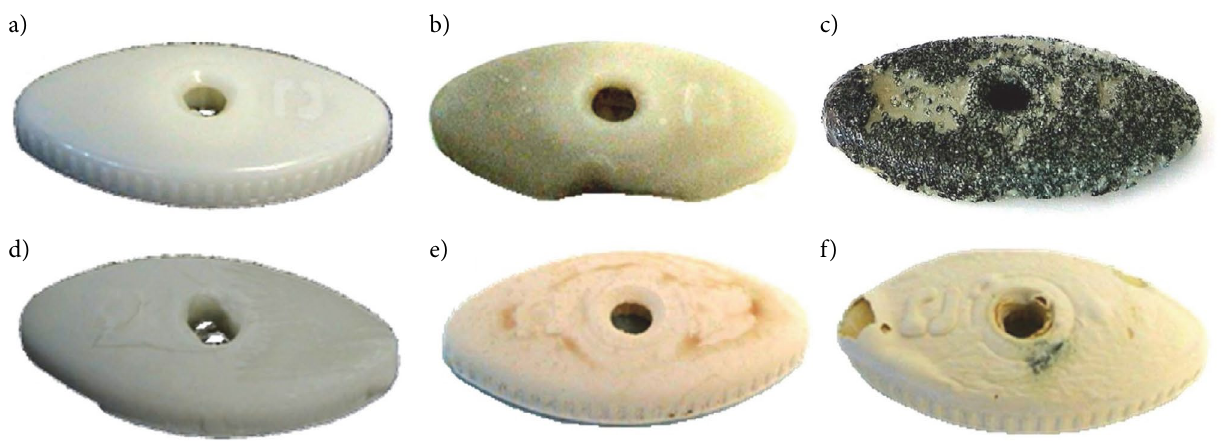
Figure 5. A piece of ABS without dye: (a) without treatment, with chemical treatment, and conditioning with the sulfuric-chromic acid bath (350 g/L): (b) Diethyl Oxalate; (c) phenetole; (d) Acetone; (e) Methanol; with chemical treatment and conditioning with sulfuric-chromic mixture (75g/L): (f) nitric acid.